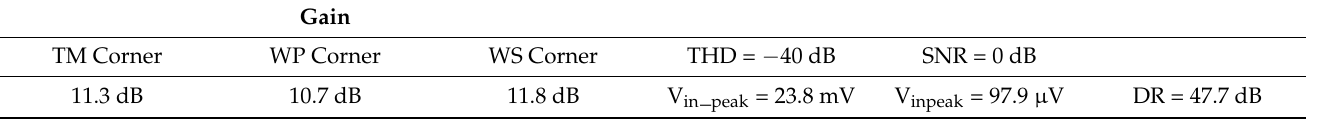
Table 17. Behavior of mid-band filter gain in corner analysis and dynamic range.